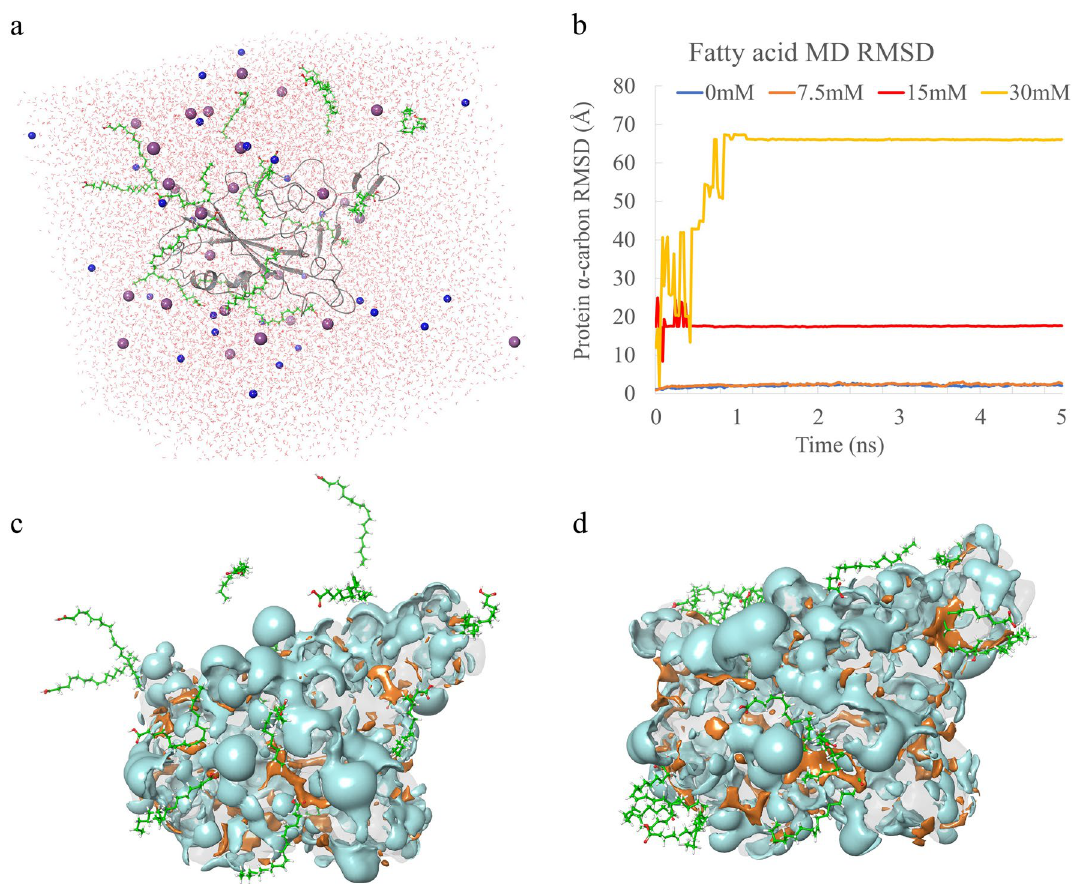
Figure 6. ( a ) Snapshot of initial frame of RBD (gray) with 30 mM fatty acid (green) in solvent model. TIP3P water models were red, sodium ions were blue, and chloride ions were purple. ( b ) RMSD plots of RBD with different concentrations of fatty acids. Initial snapshot ( c ) and final snapshot ( d ) of RBD hydrophobic (orange) and hydrophilic (cyan) surfaces with 30 mM fatty acid (green).